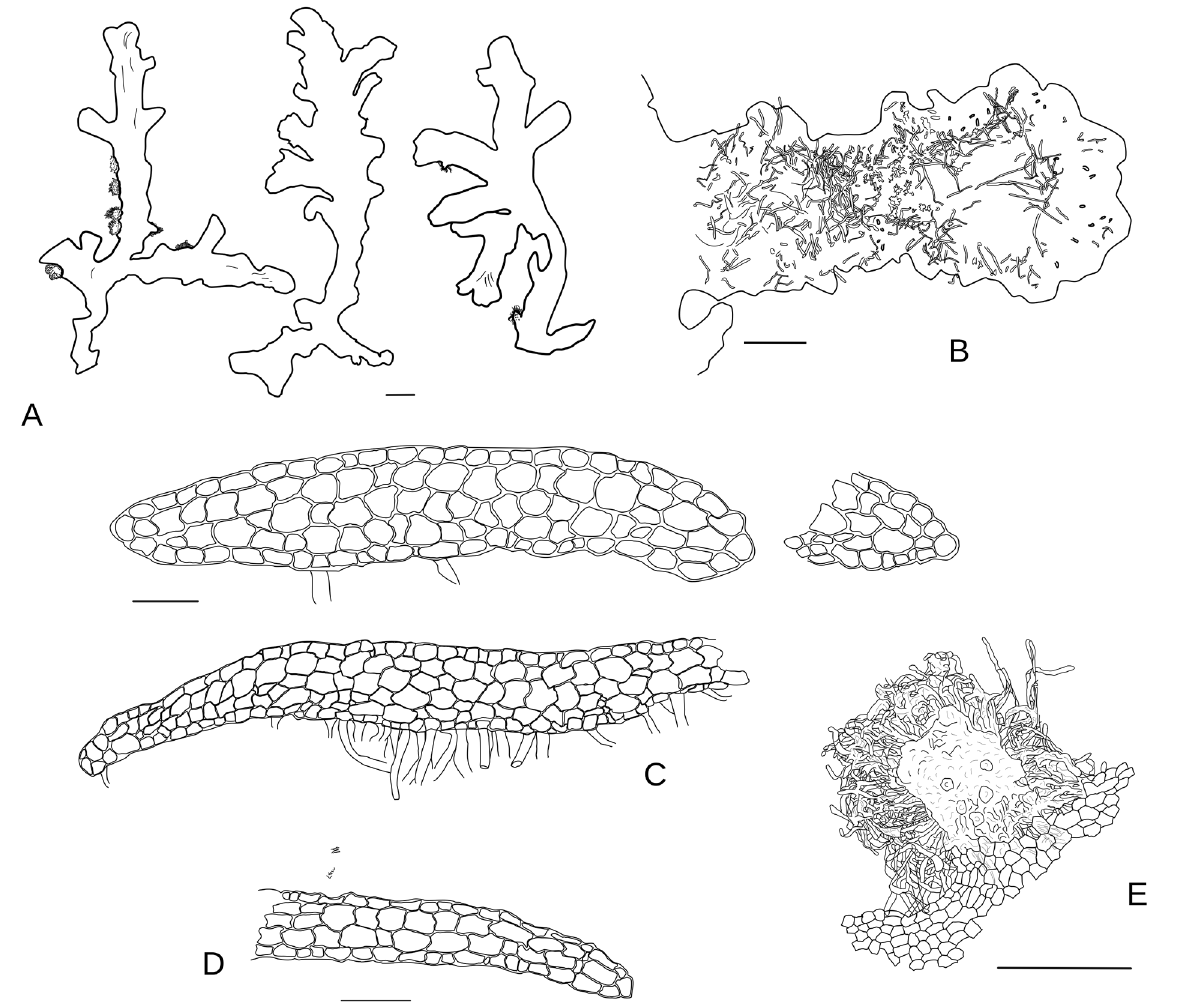
Fig. 4. Afroriccardia comosa (Steph.) Reeb & Gradst. comb. nov. A . Habit of the thallus, Wigginton U5039a , Reeb & Andriamanantena CR13Z28 . B . Ventral face showing the wide insertion of rhizoids, DeLisle 220 . C . Cross section of main axis showing variability in the thickening of cell walls, Reeb & Andriamanantena CR13Z28 , holotype G0045027. D . Cross section of ultimate branch, holotype G0045027. E . Detail of female branch with dense cluster of rhizoids, holotype G0045027. Scale bars: A–B = 1 mm; C = 100